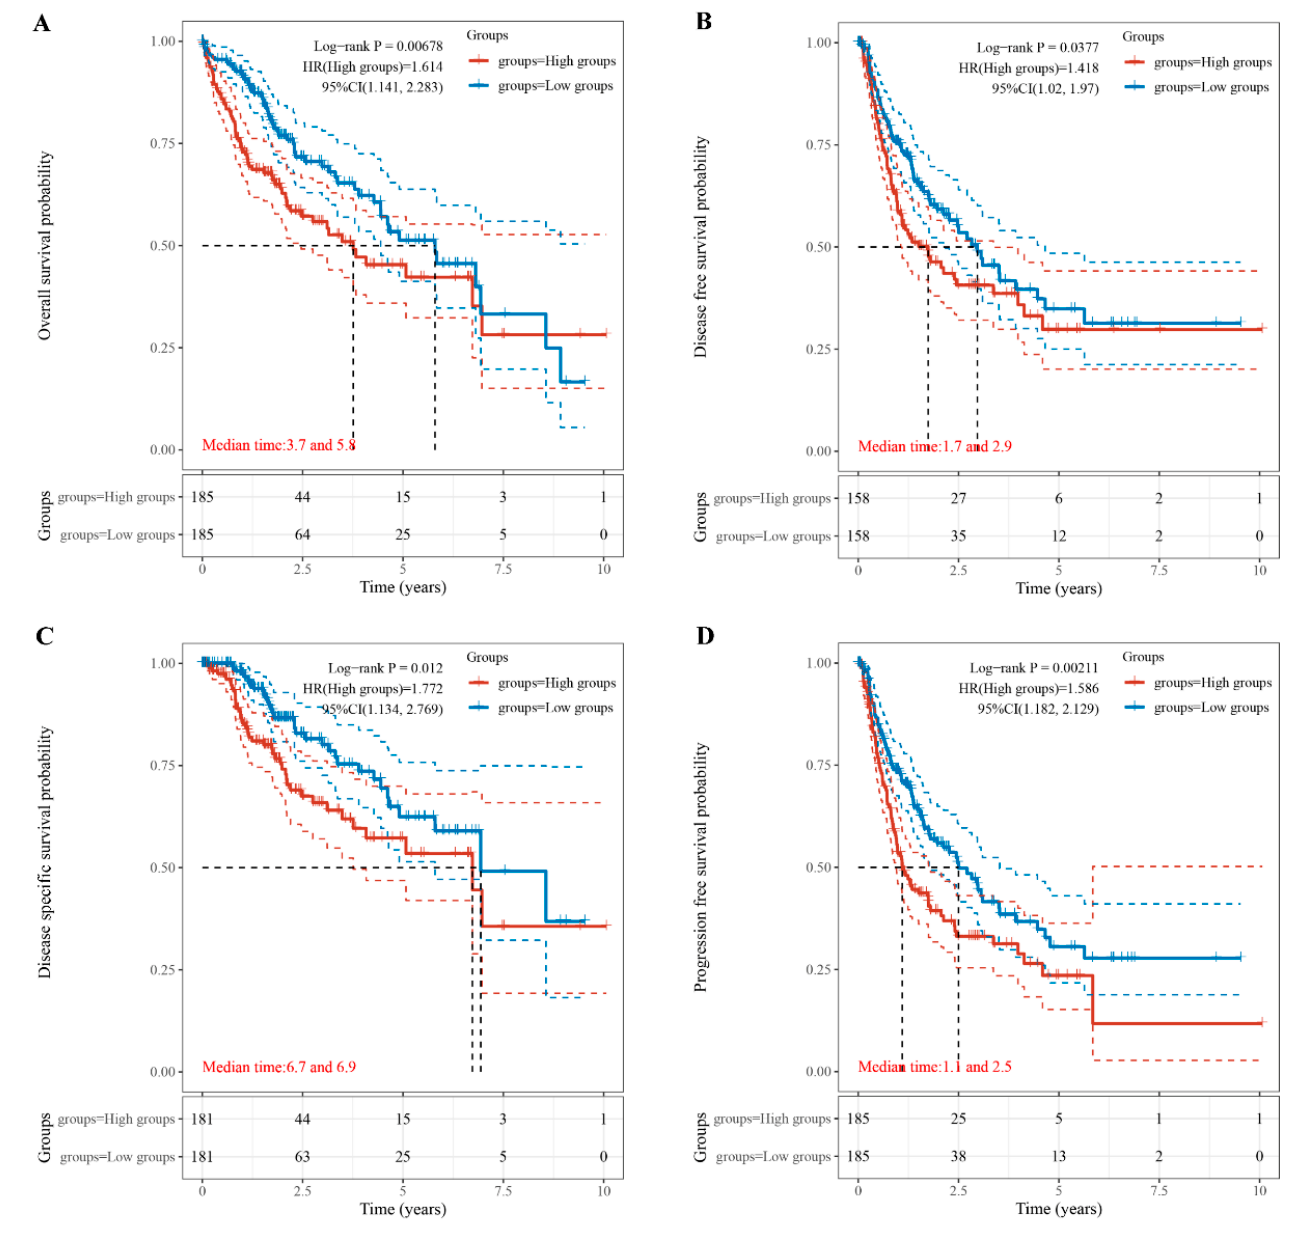
Figure 2. Relationship of TUBA1B expression with OS, DFS, DSS, and PFS. ( A ) High TUBA1B expression groups had a shorter OS. ( B ) High TUBA1B expression groups had a shorter DFS. ( C ) High TUBA1B expression groups had a shorter DSS. ( D ) High TUBA1B expression groups had a shorter PFS. The upper and lower dashed lines are 95% confidence intervals (CI).